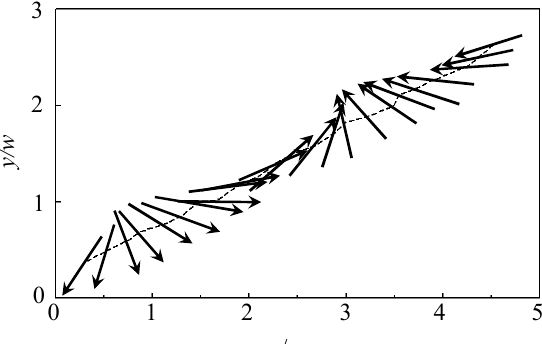
Fig. 6 Locus of a falling plate ( λ = 0.3, AR = 10, I * = 3.29, Re ( V ) = 1.79 × 10 3 , ( Re = 1.8 × 10 3 – 2.3 × 10 3 ), C = 3.86 × 10 2 ). Arrows and a dotted line denote the cross-section direction of a plate and the trajectory of a plate’s centre,